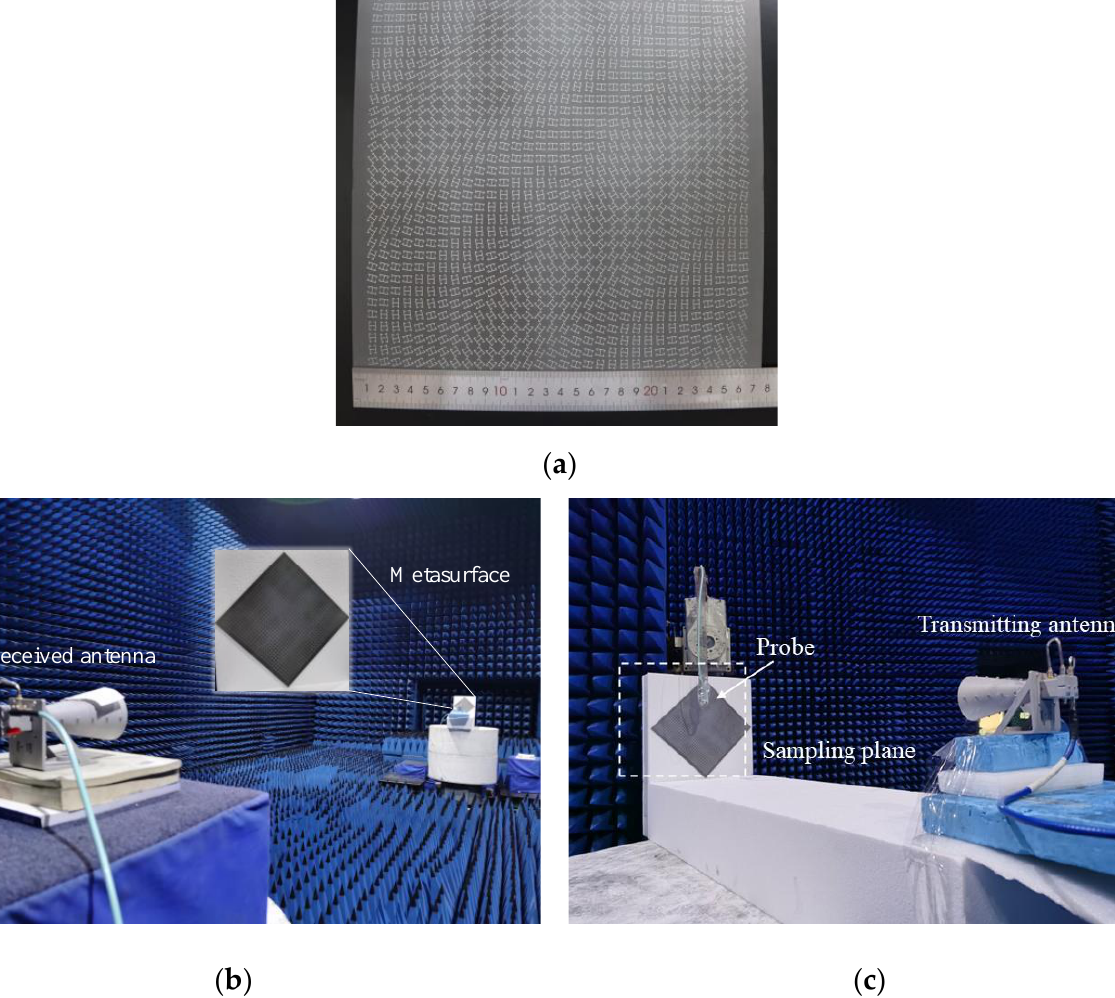
Figure 6. Photograph and testing environment. ( a ) The photograph of the manufactured metasurface. ( b ) Far-field testing environment. ( c ) Near-field testing environment.